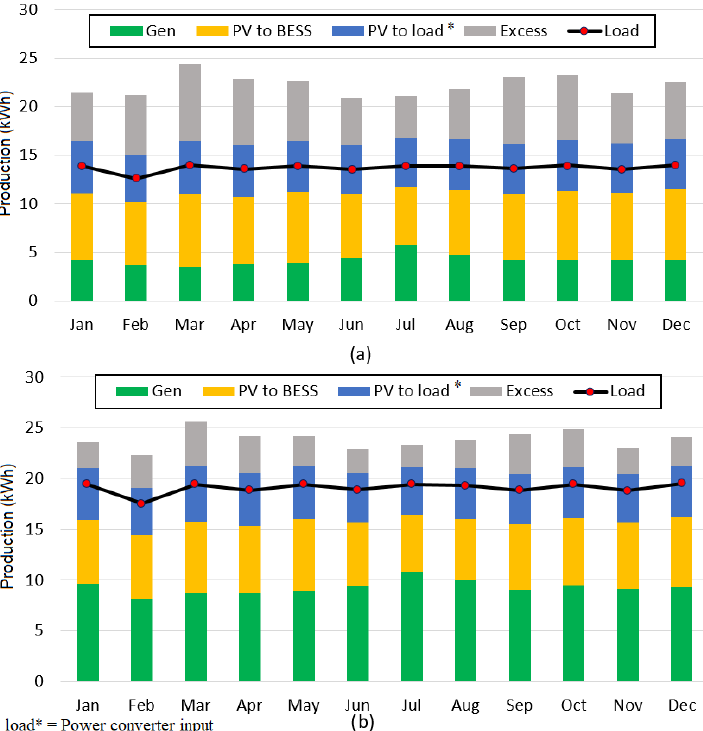
Figure 12. Power production from SPVSs and energy consumption of the electrical load in the year 15, ( a ) CEEI, and ( b ) CWEEI.